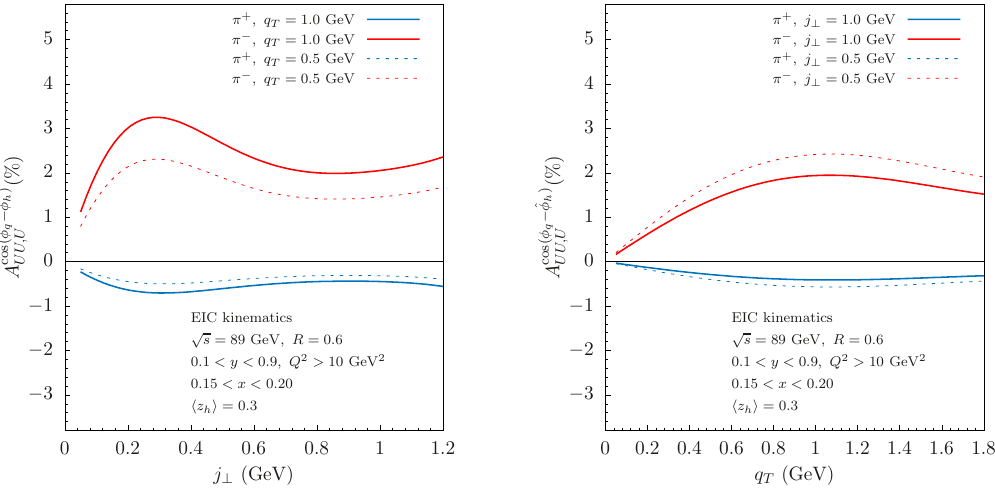
ˆ φ h ) in figures 6 UU,U